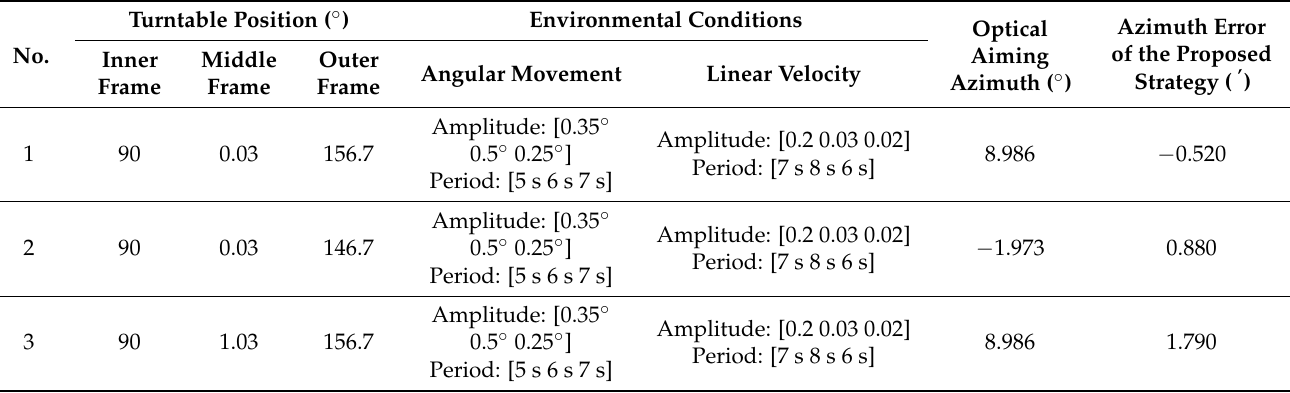
Table 7. Results of highly precise alignment of laser gyroscope inertial measurement unit dy- namic